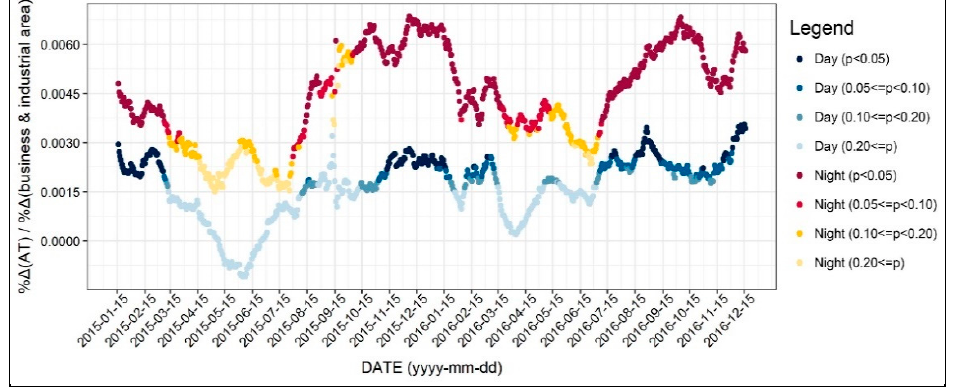
Figure 11. Changing patterns in the regression coefficients and their significances (business and industrial use).